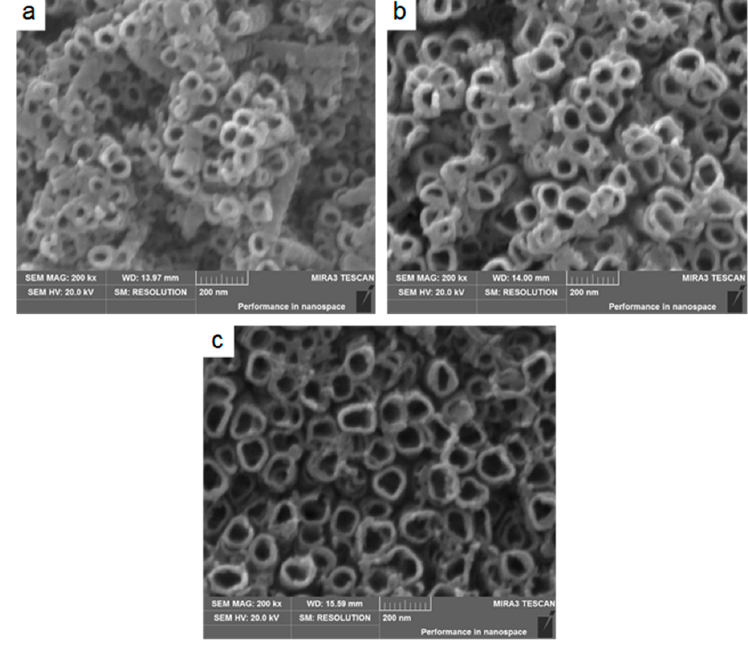
Figure 3. SEM images of nanotube arrays anodized at the following times: ( a ) 3 h, ( b ) 6 h and ( c ) 12 h, with inner diameters of approximately 44.5, 71.2 and 136.8 nm, respectively.